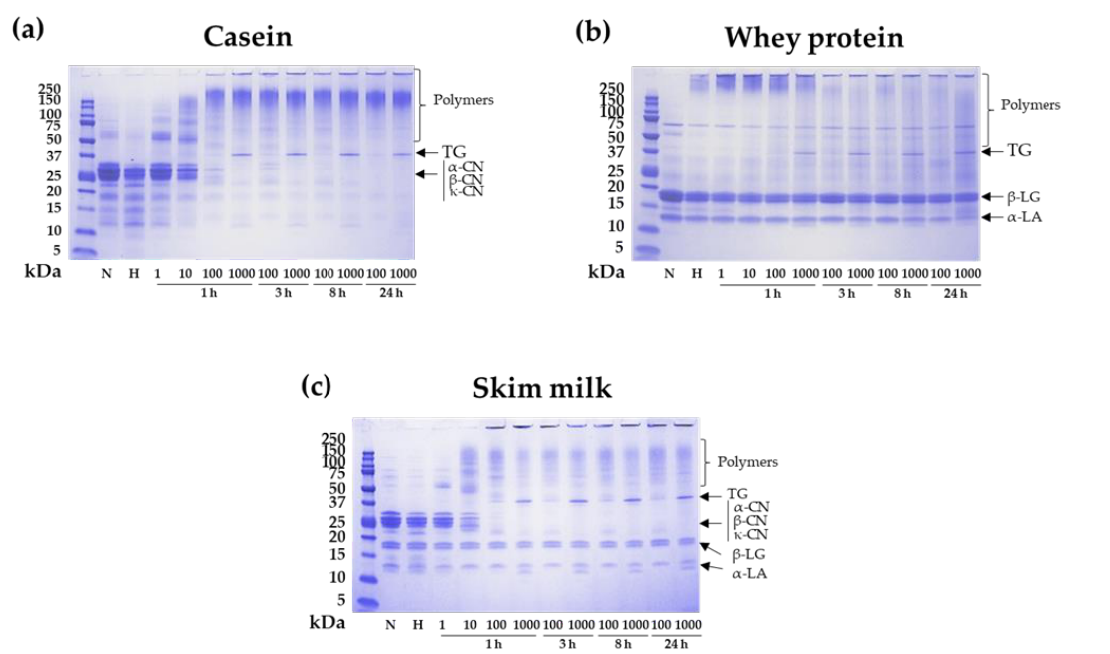
Figure 1. Electrophoretic patterns of TG treated samples. SDS-PAGE using Bis-Tris 12% acrylamide gels of ( a ) casein, ( b ) whey proteins and ( c ) skim milk after cross-linking using transglutaminase (TG) at 1, 10, 100, and 100 U of TG/g of protein during 1, 3, 8, and 24 h of incubation at 40 °C. Heating to 90 °C for 10 min to deactivate the TG was applied to the samples. Native (N) and heated (H, 90 °C for 10 min) proteins were included as control samples. α - casein = α - CN, β - casein = β -CN, k-casein = k- CN, β - lactoglobulin = β - LG and α - lactalbumin = α -LA.